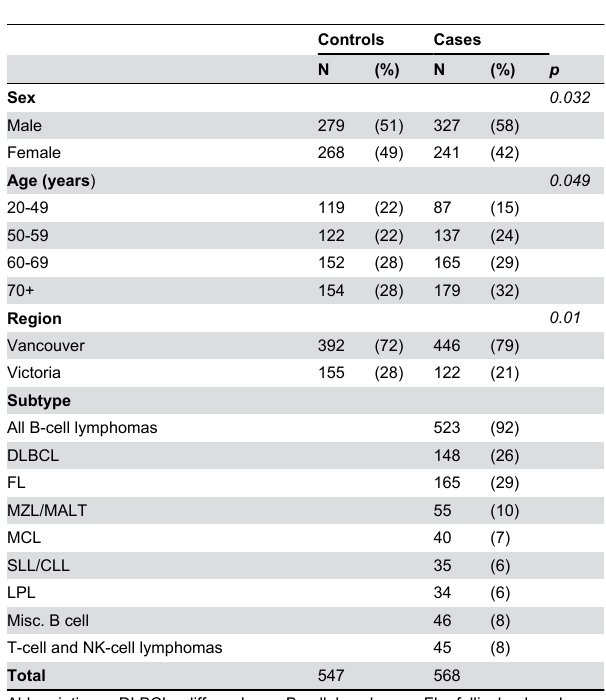
Table 1. Characteristics of the BC study population.